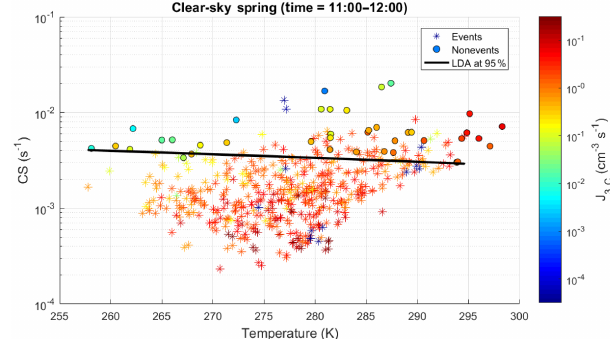
Figure 11. Relationship between temperature and CS during spring- time (11:00–12:00) NPF clear-sky ( P >0.7) event days and non- event days color-coded with J 3 ,C . Horizontal line is calculated from LDA at 95% confidence relative to nonevents and is demonstrated by Eq.